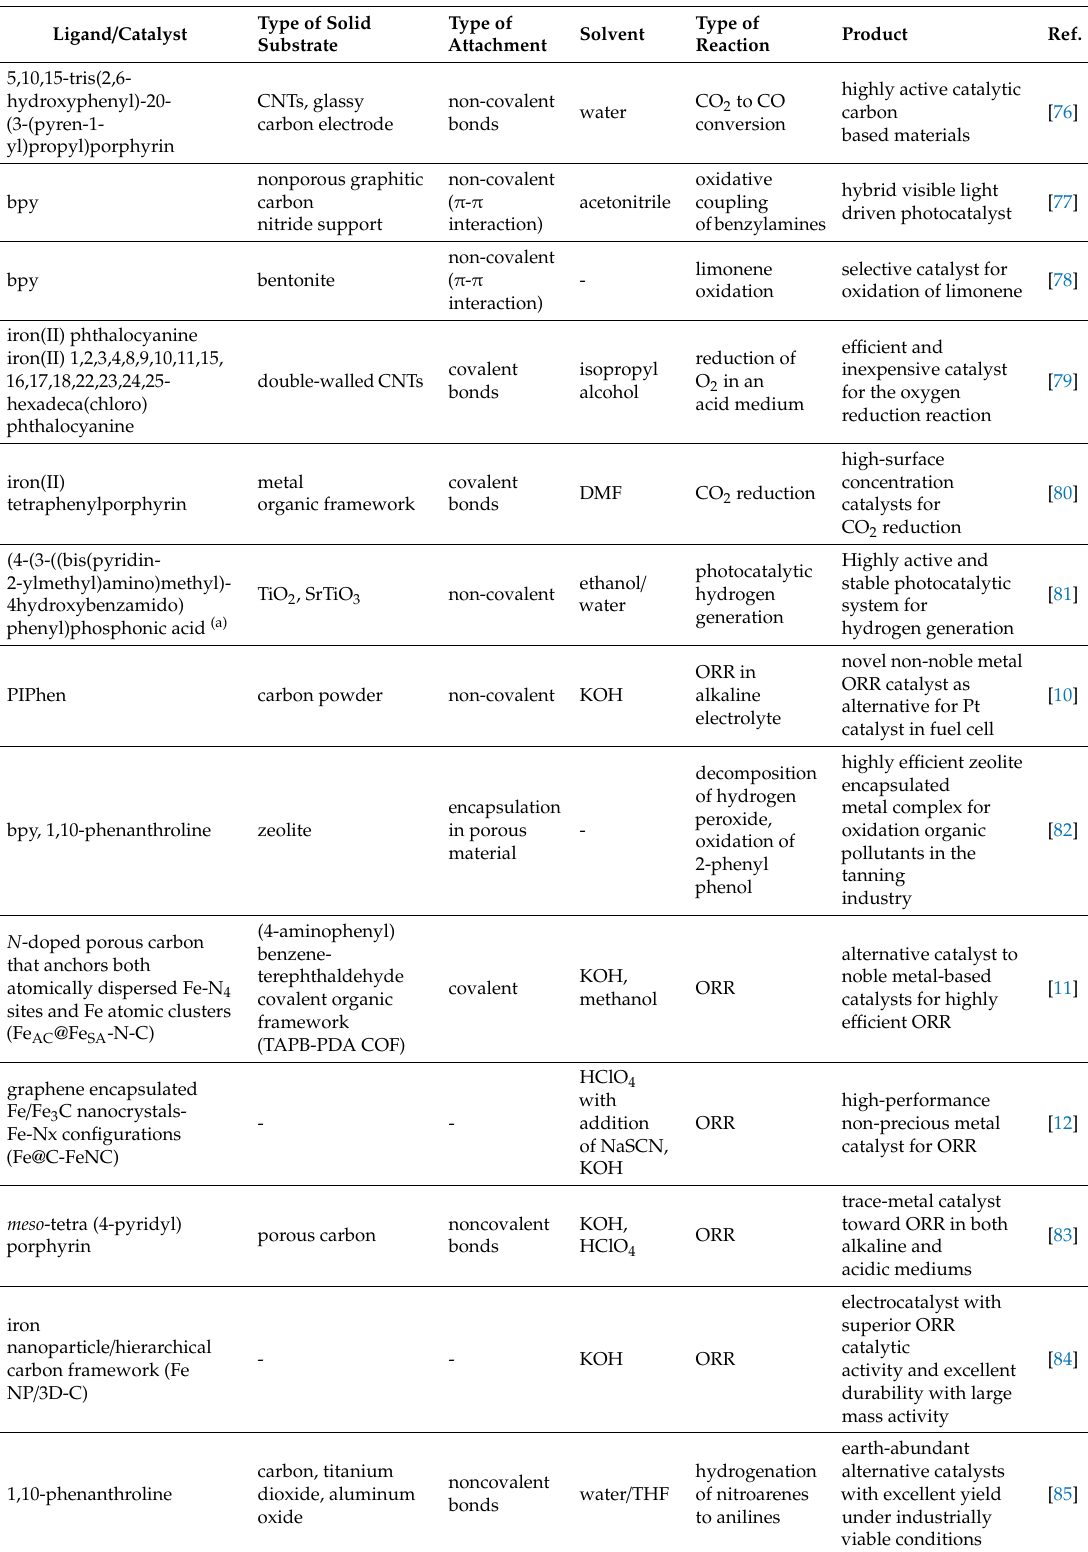
Table 2. A summary of iron complexes with nitrogen-containing ligands applied in homogeneous catalysis.